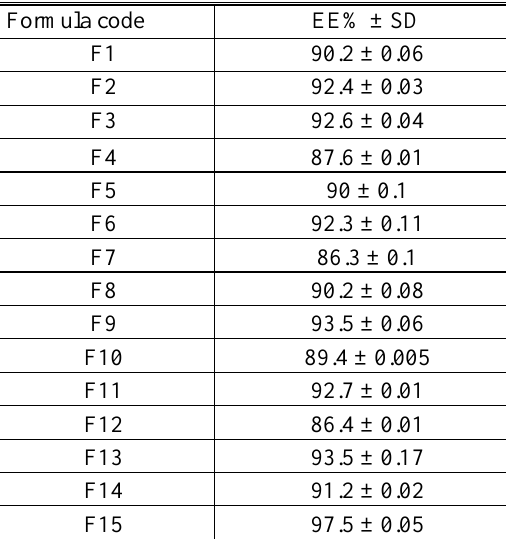
Table 5. EE values of the prepared formulas Formula code